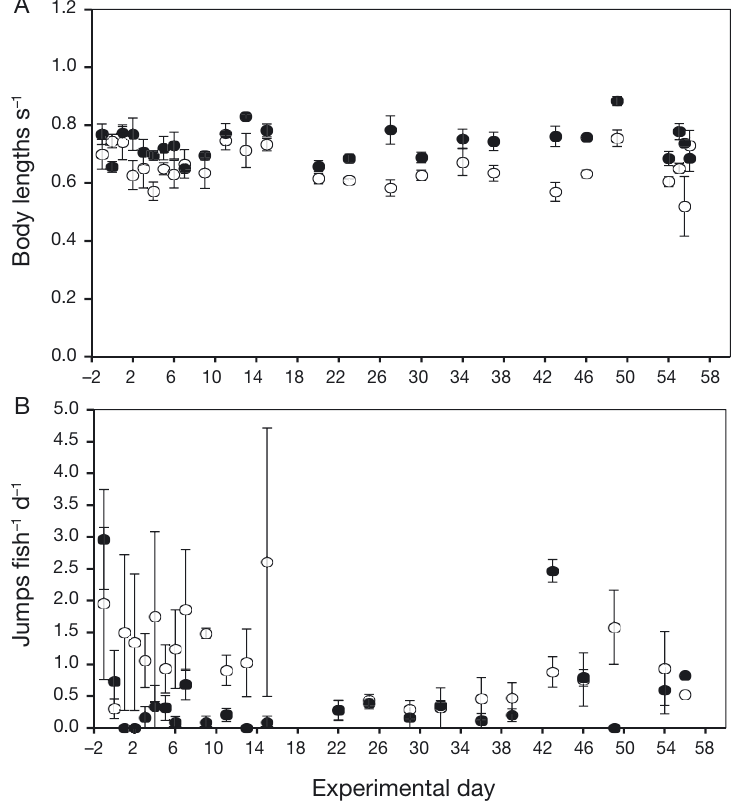
Fig. 3. (A) Swimming speeds and (B) breaches of Atlantic salmon in the control ( s ) and snorkel ( d ) cages over the 58 d experimental period for Expt 2. Each point is the mean instantaneous swimming speed of 30 fish